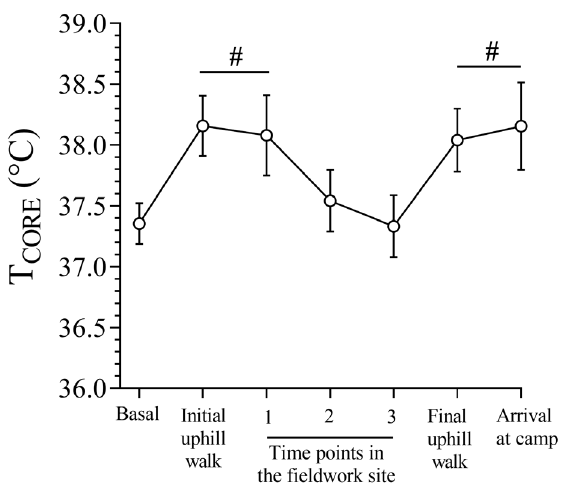
Figure 1. Core body (gastrointestinal) temperature measured throughout a typical day of work in the camp (n = 7). Basal : at the camping, at the beginning of a workday. Initial uphill walk : after about 22 min of walking up a sloping hill, which was required to move away from the camp. Time points in the fieldwork site: these measurements were carried out during the researchers’ specific activities (i.e., excavations and handling artifacts); in particular, the Time point in the fieldwork site measurements were performed : 1 ) when arriving at the main point of archaeological excavation after about a 50-min walking; 2 ) One hour after the last data collection; 3 ) at the end of work on the excavation site. Final uphill walk: after about 40 min of walking up a sloping hill, which was required to move away from the fieldwork site, in the exact same location of the Initial uphill walk . Arrival at camp : at the camping, at the end of a workday. # Significantly different (P < 0.05) from the basal and time points 2 and 3 in the fieldwork site. The data are expressed as means ±